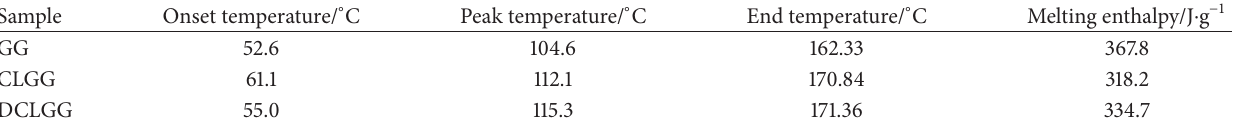
Table 7: Onset temperature, peak temperature, end temperature, and melting enthalpy.